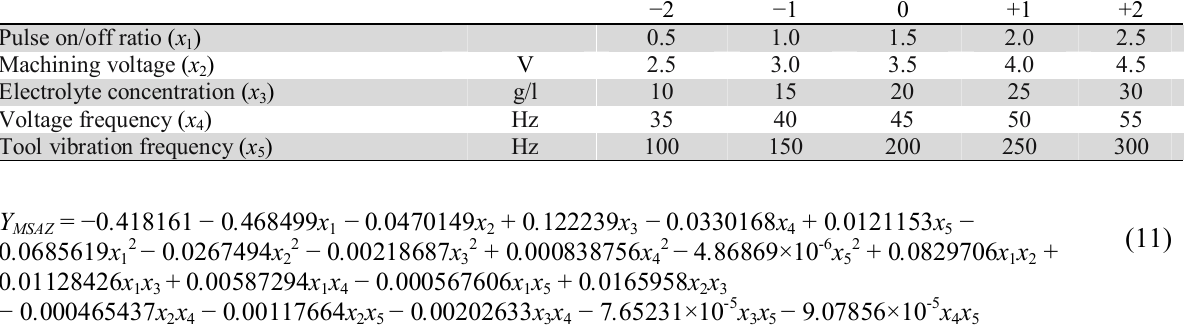
EMM process parameters and their levels (Munda et al., 2007) Parameter